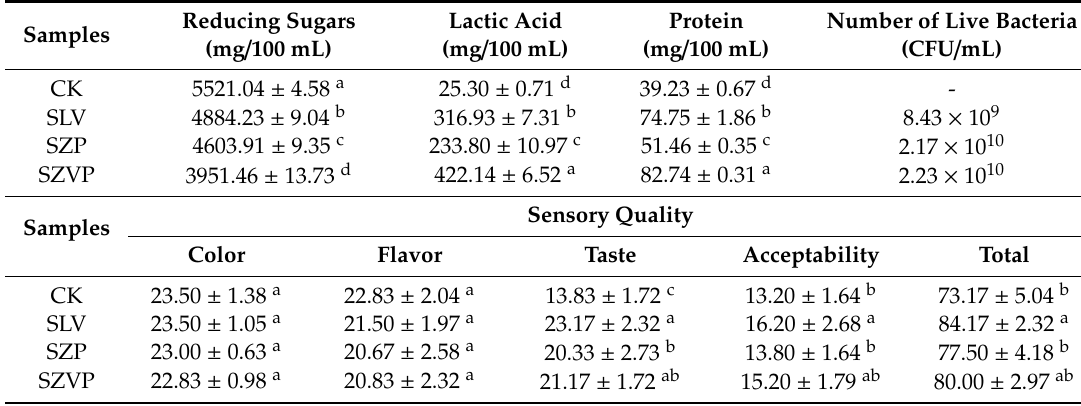
Table 1. Comparison of fermentation characteristics of each composite strain